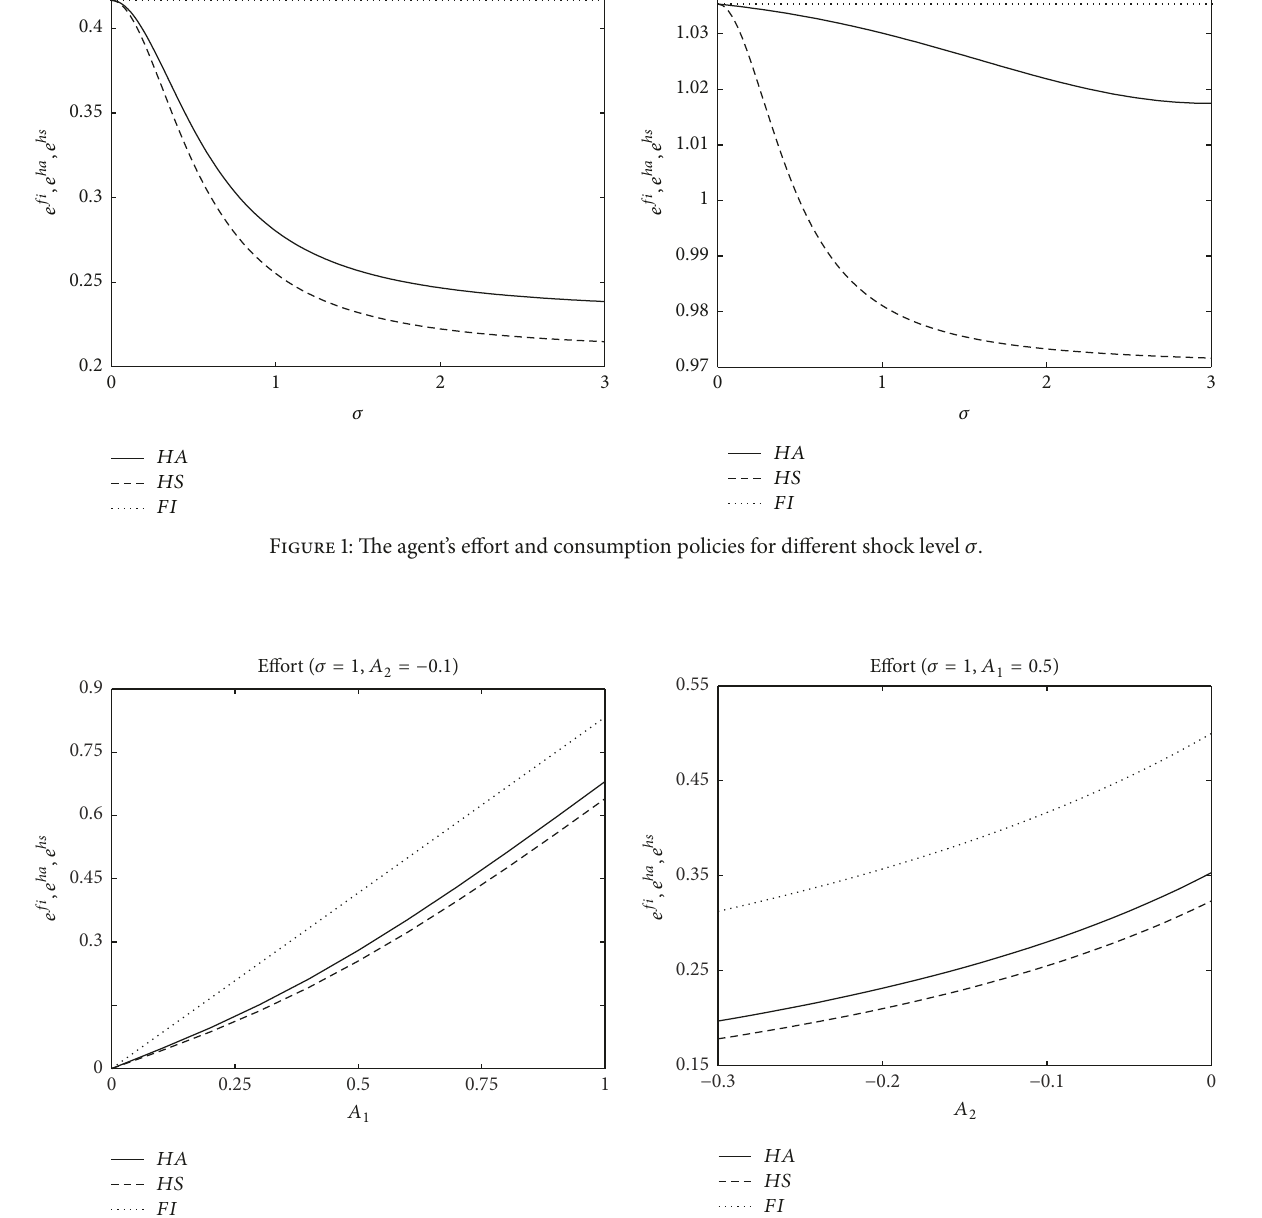
Figure 2: The agent’s optimal effort for different 𝐴 1 and 𝐴 2